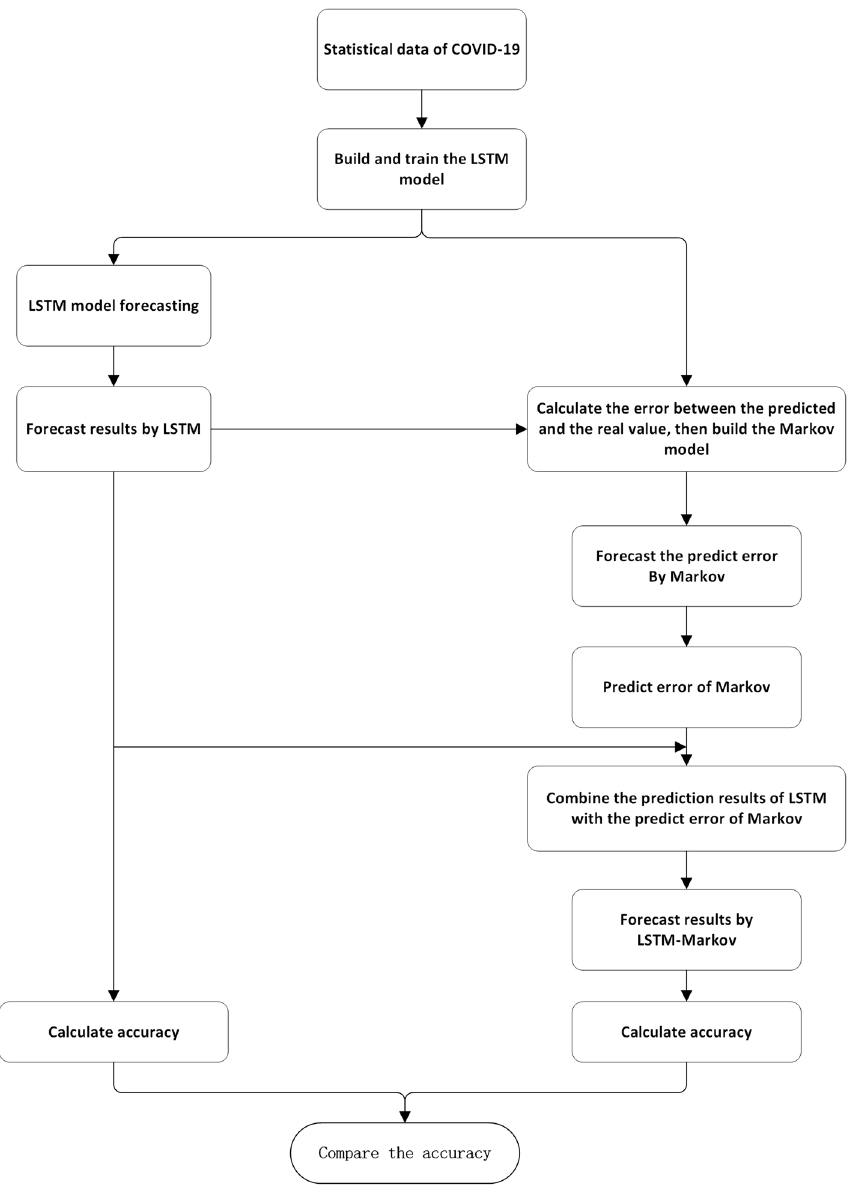
Figure 4. The main steps in predicting confirmed COVID-19 cases by LSTM-Markov (Figure was edited by